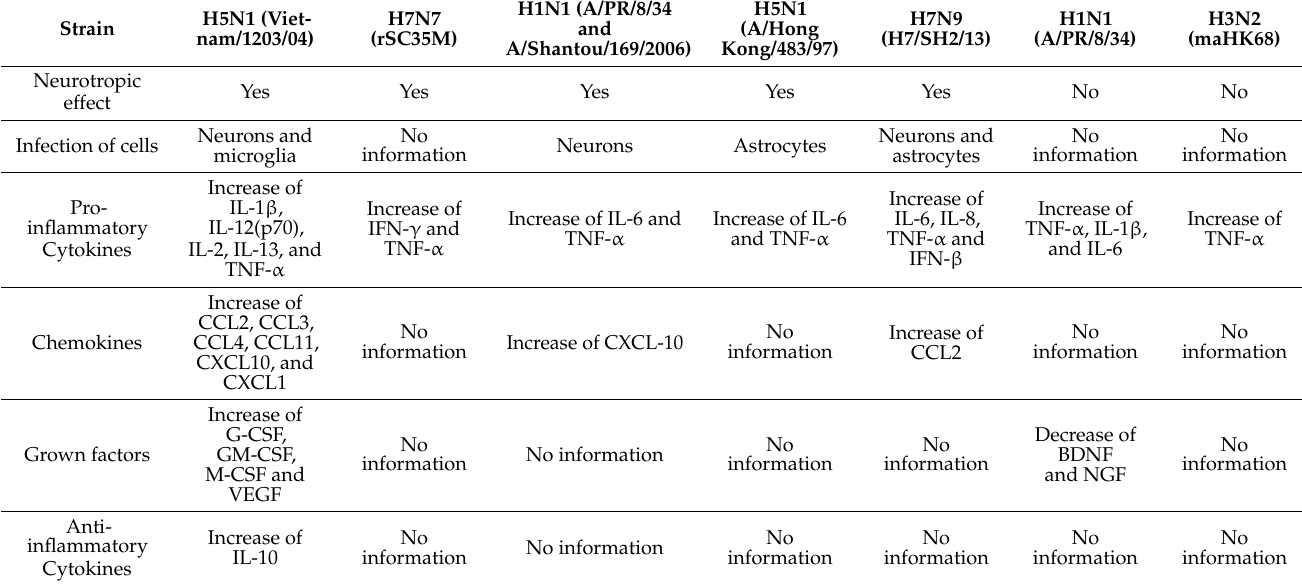
Table 1. Cytokine profile elicited by the influenza virus